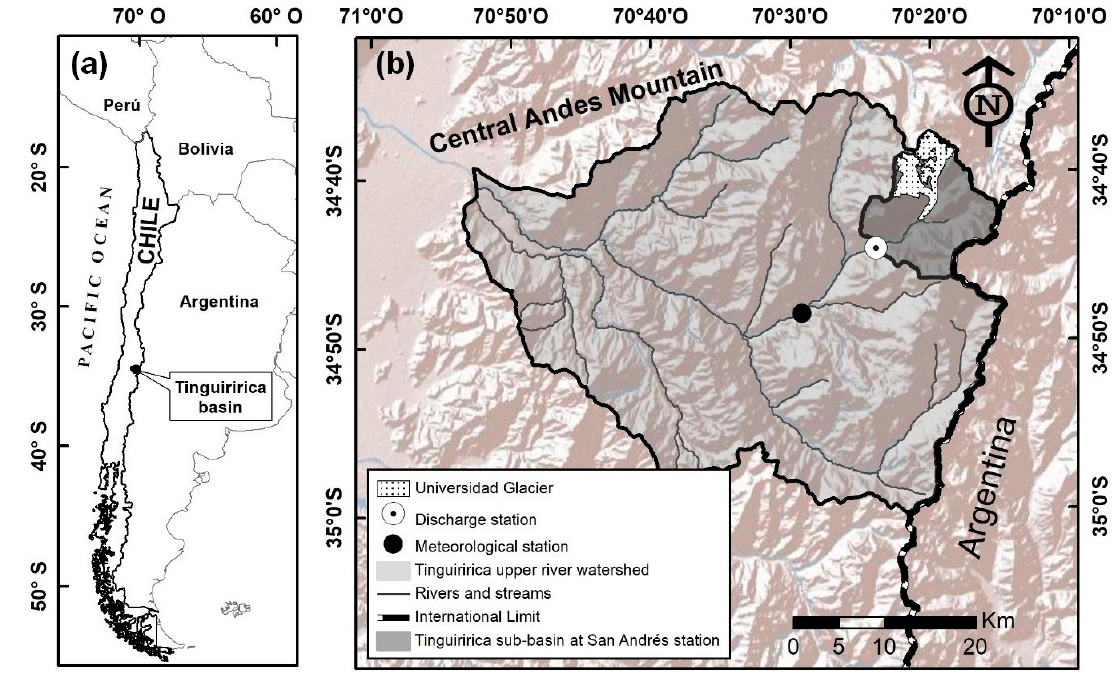
Figure 1. Location of study watershed, Universidad Glacier: ( a ) Geographic location of the Tinguiririca River watershed and international borders; ( b ) location of the upper Tinguiririca River watershed and studied sub-basin.